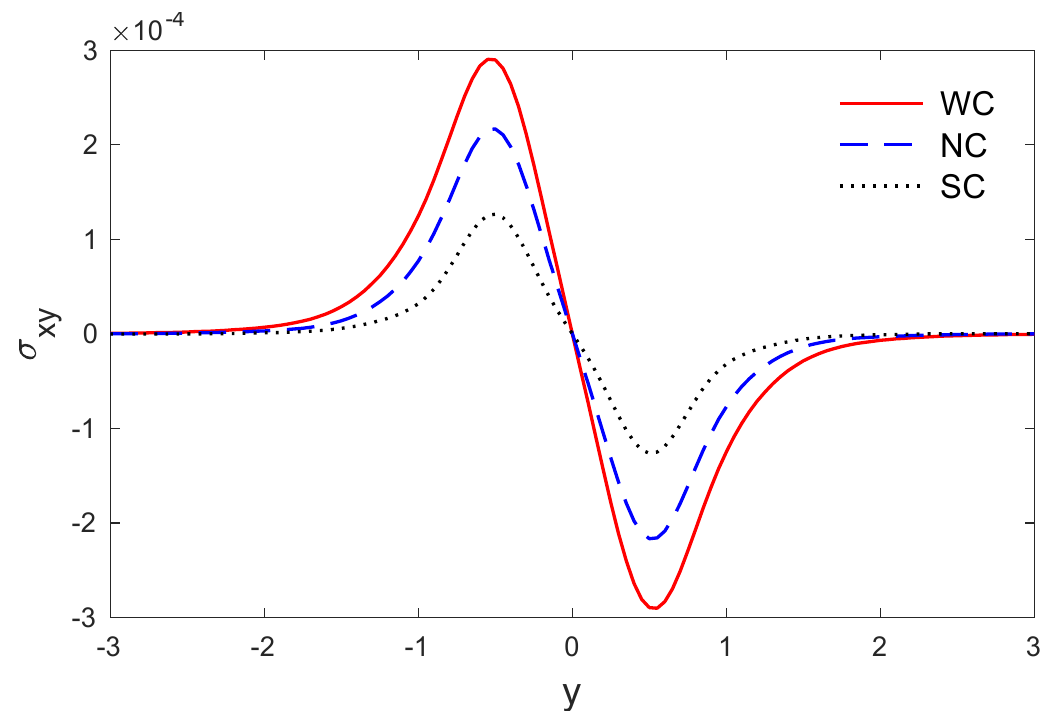
Figure 11. The variation of stresses component σ xy versus y when x = 0.4 for strong normal and weak conductivities.